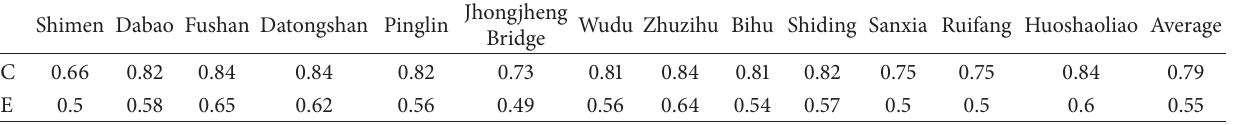
Table 3: Coefficients of correlation and efficiency in the dataset of calibration.